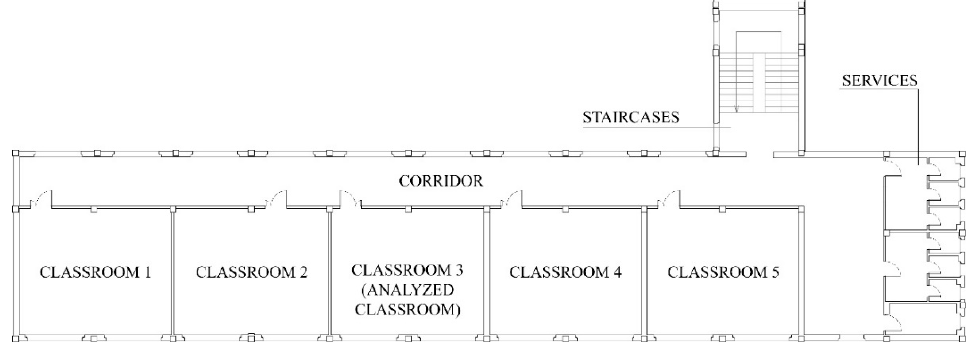
Figure 1. Scheme of the typical school floor.